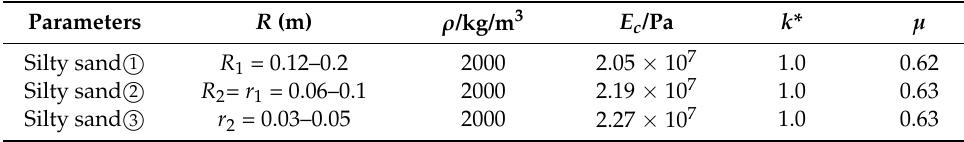
Table 2. Micro-parameters of silty sand in the DEM model.